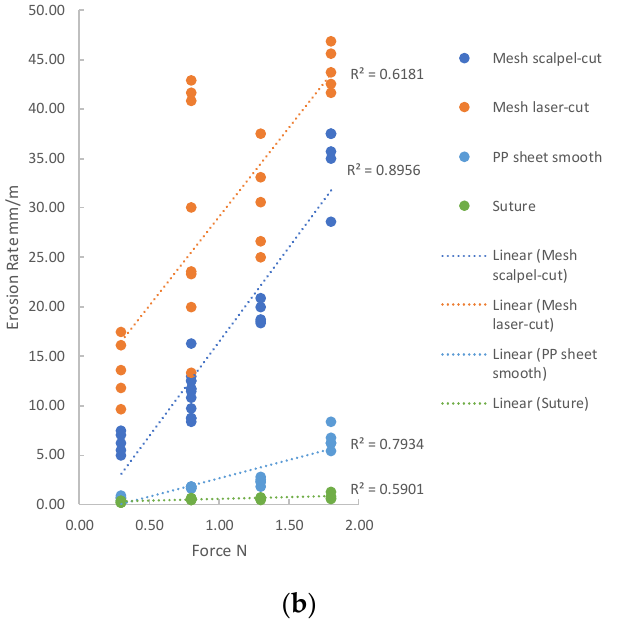
Figure 8. All results from tests using a stroke of 20 mm. Measured erosion rate as a function of applied force. ( a ) and ( b ) are two graphs with different vertical scales are used to best present the data. The lines indicate the results of best-fit linear approximations to the data, with accompanying R 2 values.